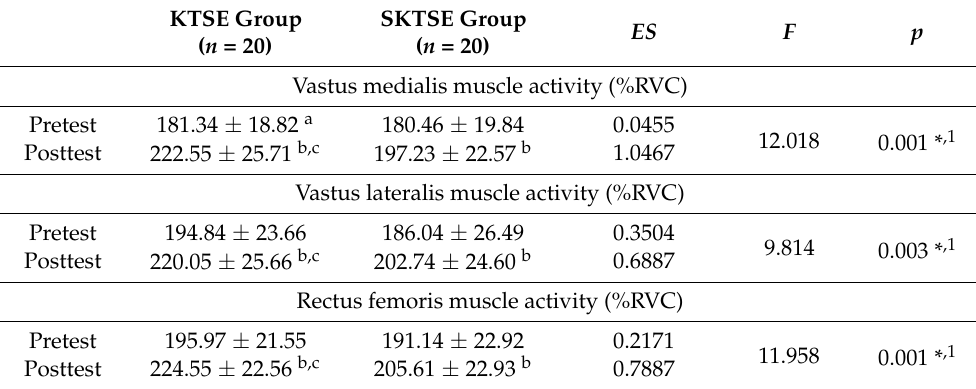
Table 2. Comparison of muscle activity between the KTSE and SKTSE groups.